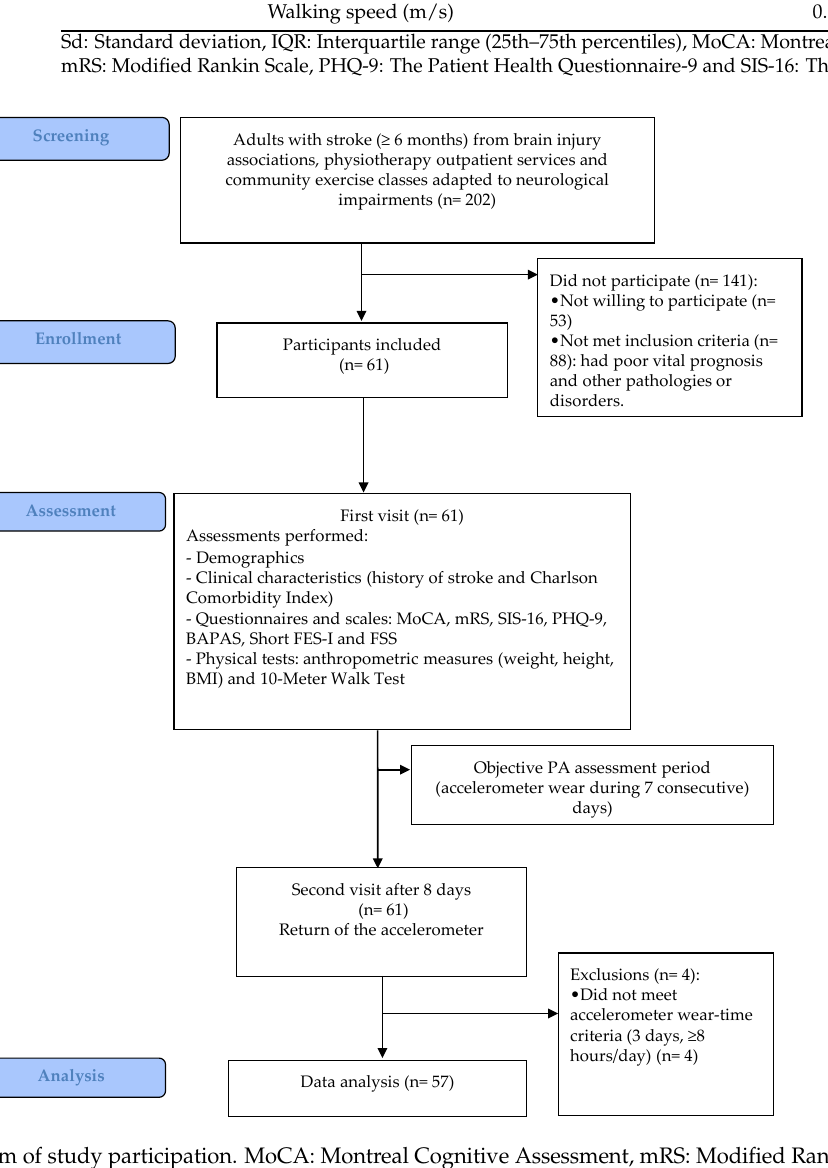
Figure 1. Flow diagram of study participation. MoCA: Montreal Cognitive Assessment, mRS: Modified Rankin Scale, SIS-16: Stroke Impact Scale-16, PHQ-9: Patient Health Questionnaire-9, BAPAS: Barriers to Physical Activity after Stroke Scale, Short FES-I: Short Falls Efficacy Scale-International, FSS: Fatigue Severity Scale, BMI: Body mass index and PA: Physical